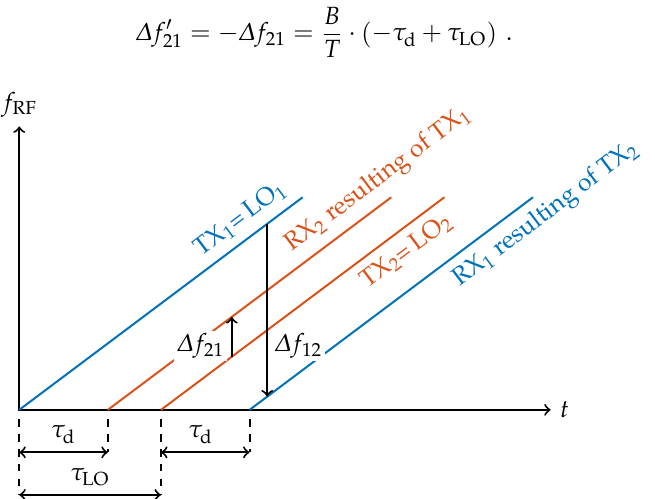
Figure 6. Schematic representation of the FMCW chirp signals transmitted and received by master and slave MMICs. Compared to the transmit signal of the master (TX 1 ) the slave’s transmit signal (TX 2 ) is delayed by the time-variant propagation time of the synchronization signal τ LO . For both forward and backward transmission the TX chirps are received at the opposite sensor after TOF τ d propagating along the direct path through the medium. The resulting BB frequencies ∆ f 12 and ∆ f 21 after down conversion of RX 1 and RX 2 with the respective LO signals LO 1 and LO 2 are depicted as arrows indicating the sign of the frequency